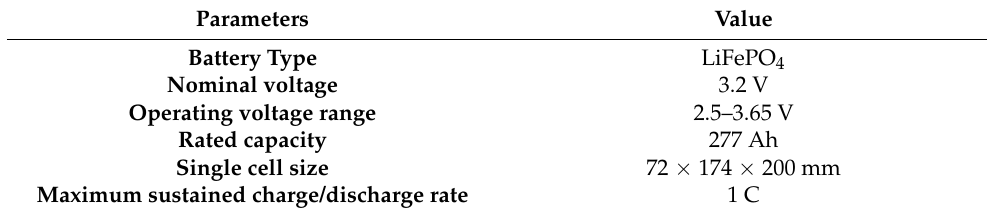
Figure 1. Battery pack heat dissipation structure: ( a ) battery pack location ( b ) battery pack internal structure. Table 1. Battery